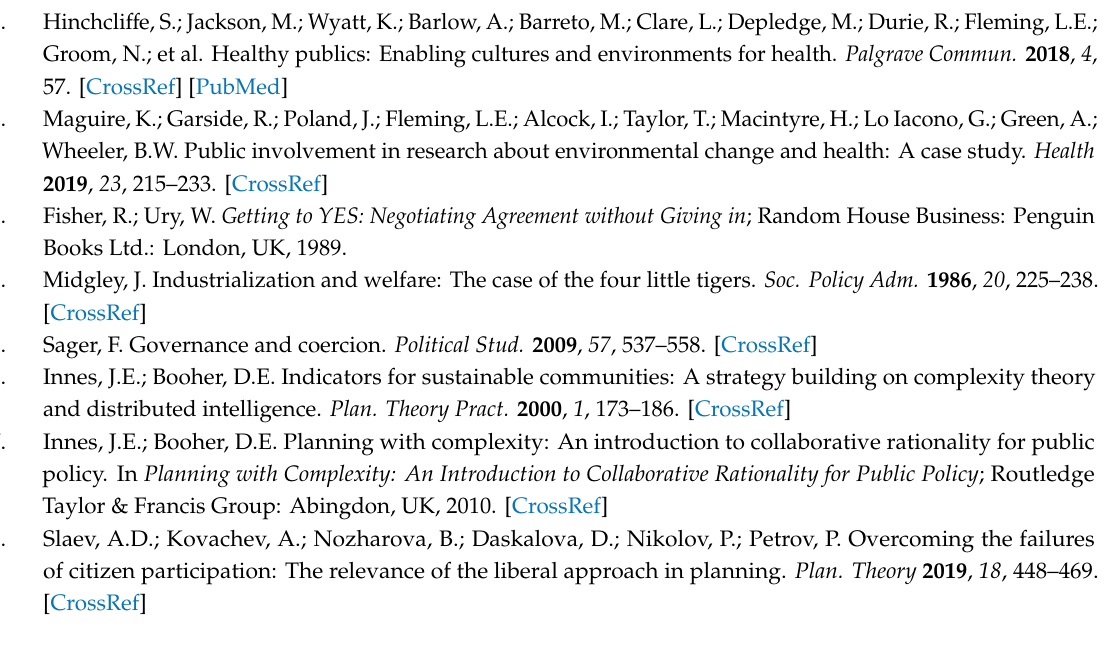
Tables S1–S4. Table S1: List of public engagement and participation activities carried out by the Chair, 2018–2020. Table S2: International and local / regional cornerstone strategies endorsed by the Chair, together with a short description of each. Table S3: List of major environmental issues together with their factors and drivers, and associated public health challenges identified by the stakeholders during the implementation phase of the Chair. Key references used are shown. Table S4: List of major human health issues and associated goals within the framework of OHH proposed by the Chair’s stakeholders. Key references used are